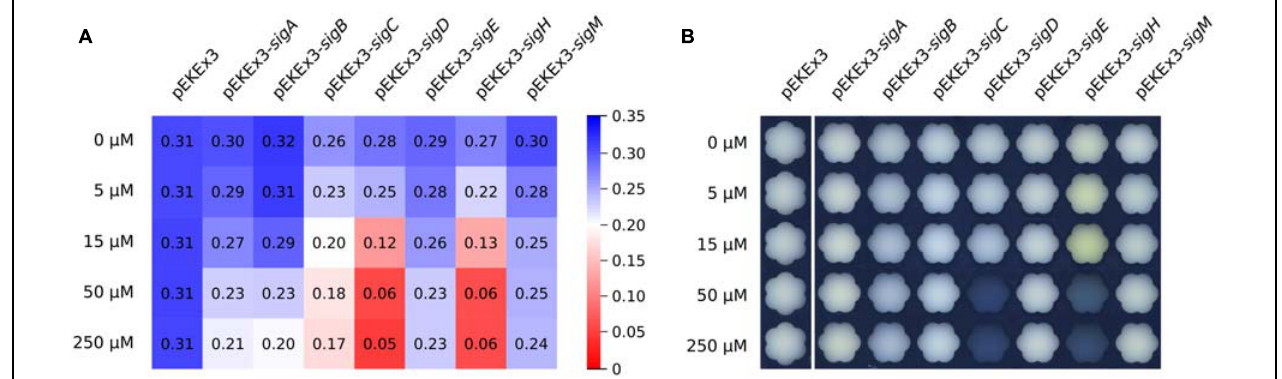
FIGURE 1 | Maximum growth rates of cultivations of C. glutamicum wild type (WT) transformed with plasmids for overexpression of various sigma factor genes (A) and images of these cultures taken after 48 h of cultivation (B). CGXII with 222 mM of glucose was used